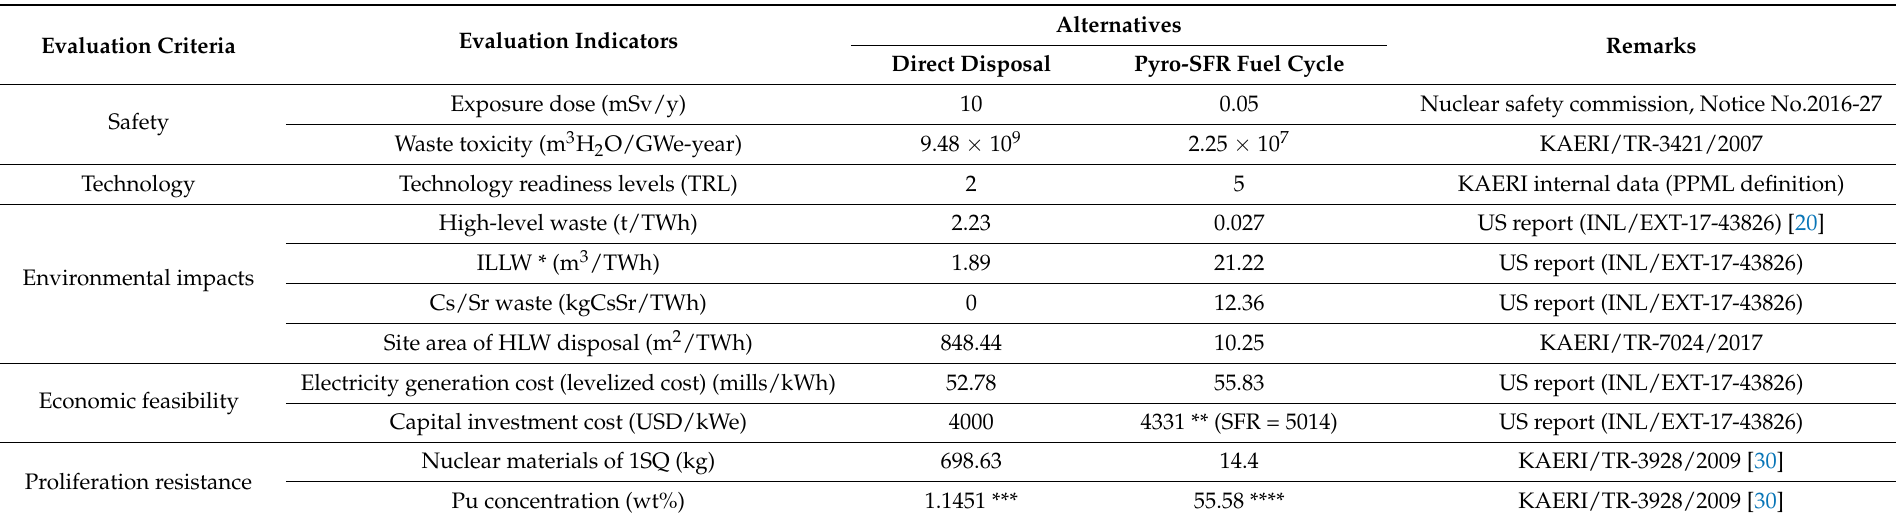
Table 2. Input data of multi-criteria decision-making